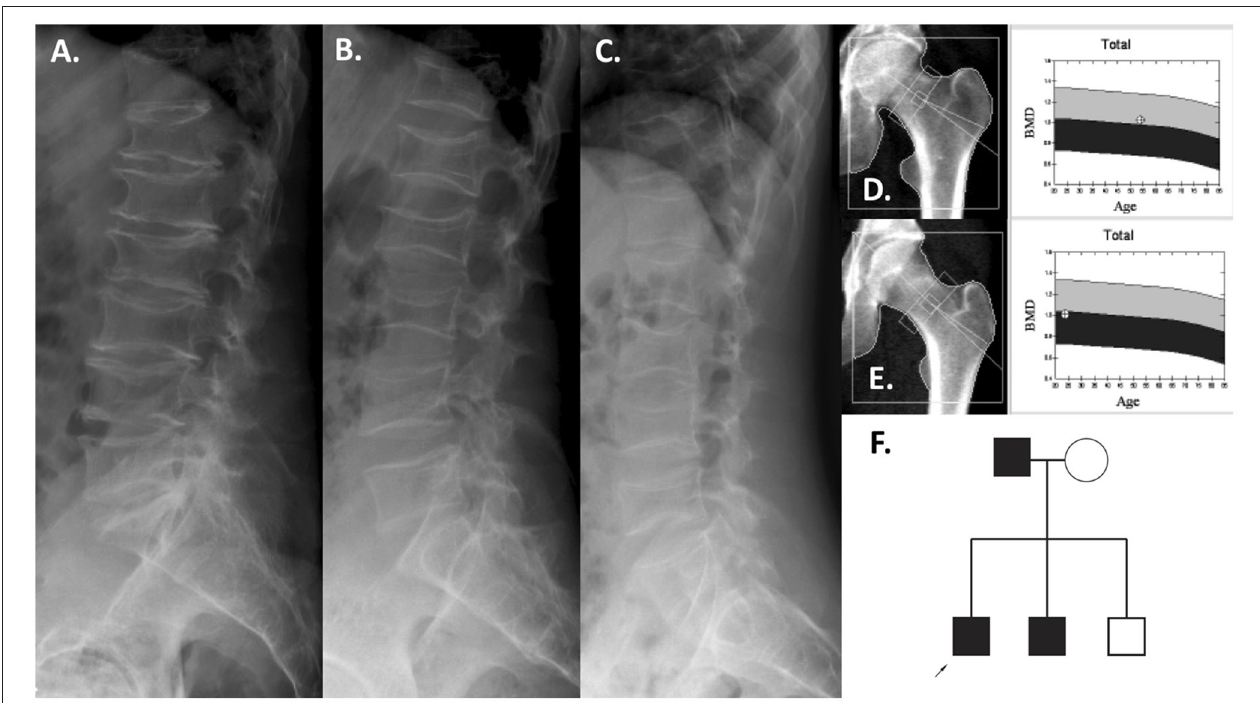
FIGURE 2 | Patients with the COL1A2 deletion. Lumbar spine radiographs of the father at 54 years (A) , the index patient at 24 years (B) , and brother at 21 years (C) . The proximal hip BMD was normal (father, D ; index patient, E ). Pedigree of the family (F) .